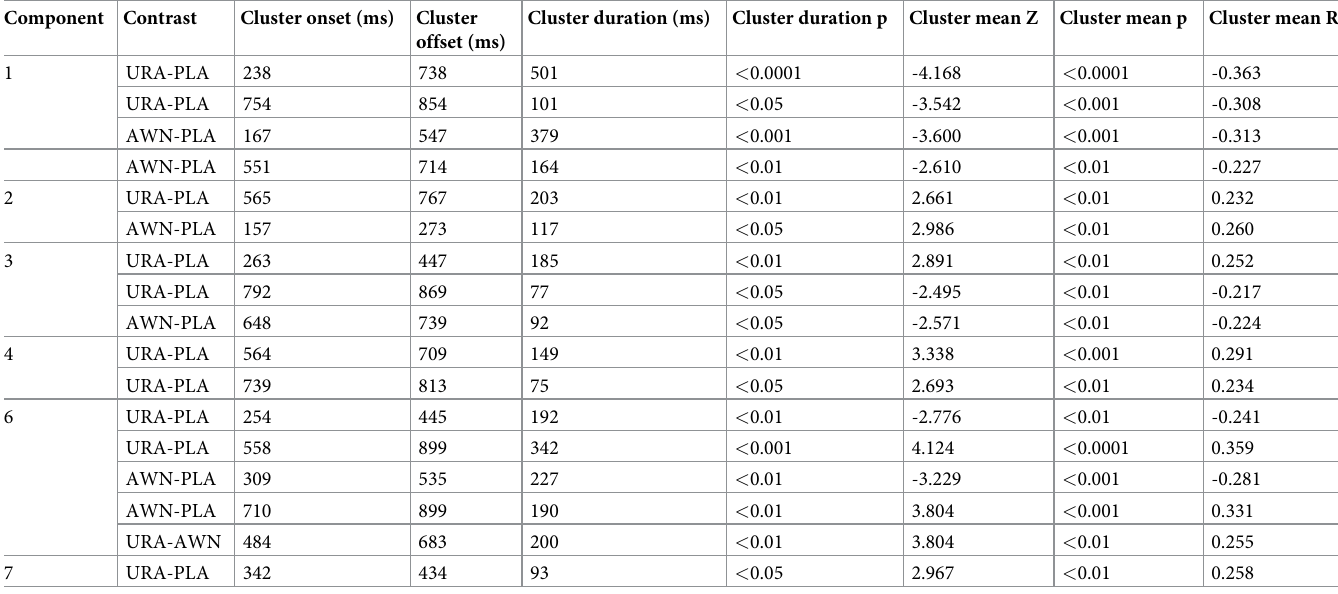
Table 5. Statistical results from the independent component